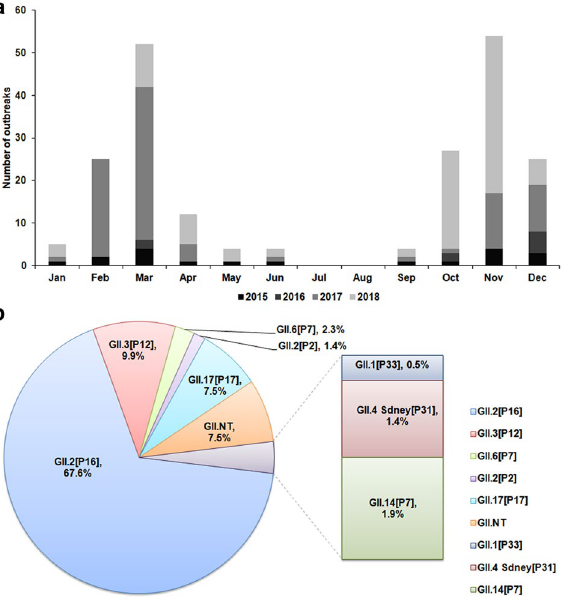
Figure 1. Norovirus outbreaks in Jiangsu, China, 2015–2018. ( a ) Laboratory confirmed number of monthly norovirus outbreaks. ( b ) Distribution of norovirus genotypes detected in norovirus